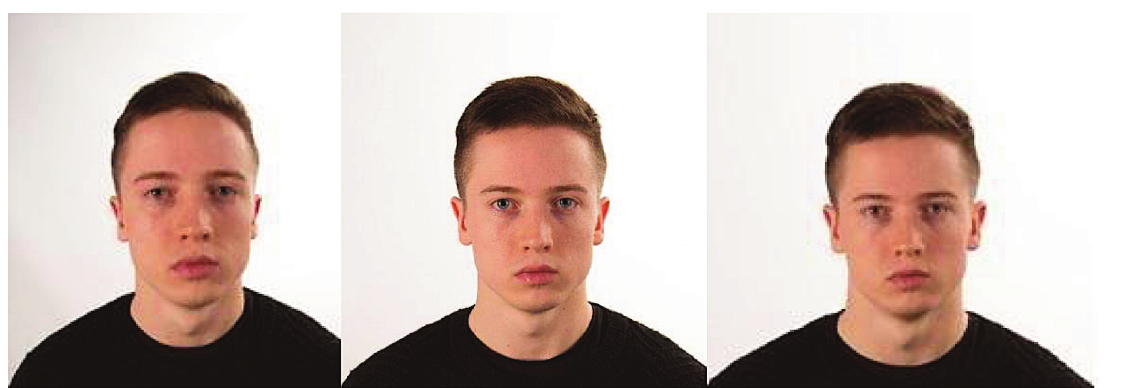
Fig. 1. 24mm, 50mm, and 100mm focal length photos of the